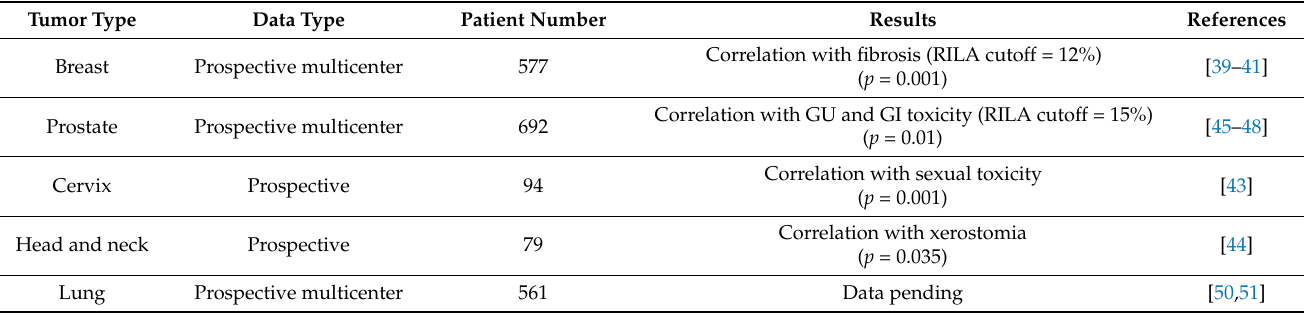
Table 1. Available data on RILA assay by tumor type. GU: genito-urinary, GI: gastro-intestinal. Tumor